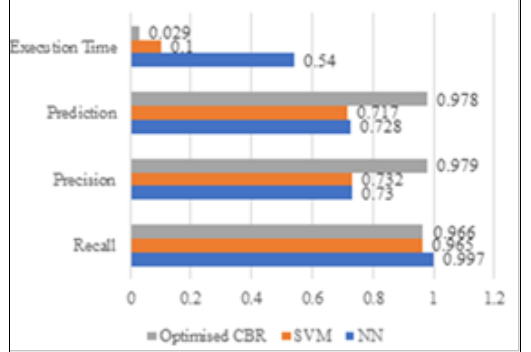
Figure 4. Comparison result of prediction for overall cross-